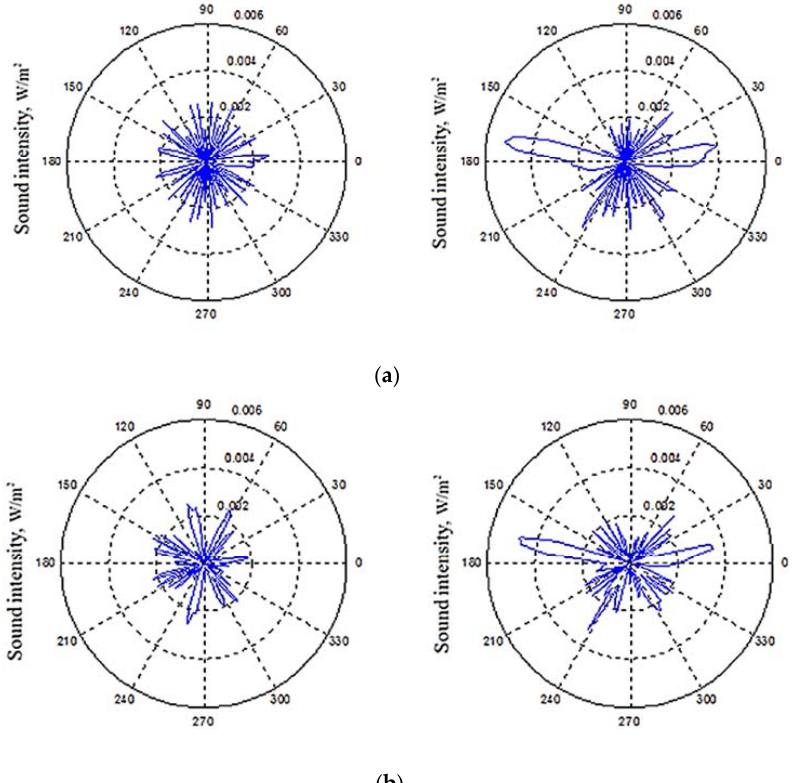
Figure 21. The intensity polar pattern diagram of uncloaked (left side) and cloaked objects (right side) with incident wave frequency f = 1250 Hz: ( a ) the intensity polar pattern of the total sound field; ( b ) the intensity polar pattern diagram of the normalized sound field (scattered field of the object).